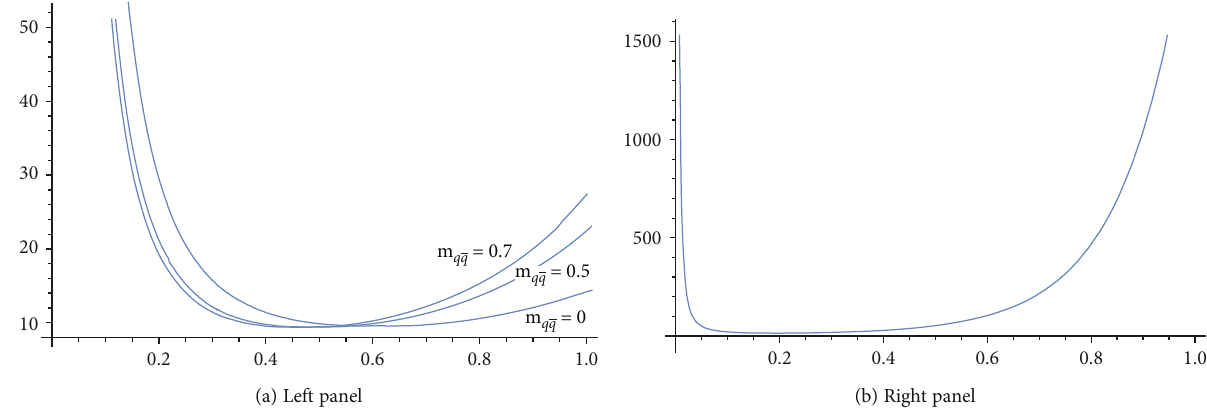
Figure 2: A graph for color dielectric function, G ð r , m